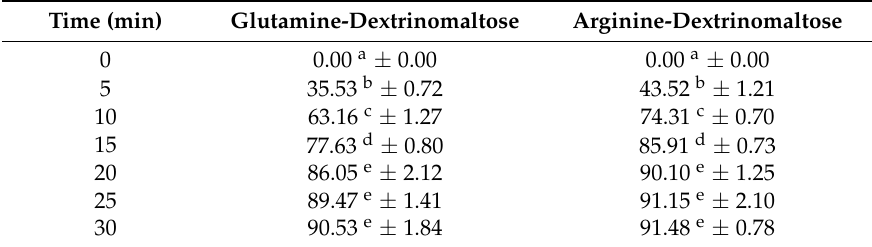
Table 1. Loss of fluorescence intensity (%) with OPA at 120 ◦ C. Values are means ± SD, n = 3; Different letters within a column indicate significant differences between groups ( p < 0.05).